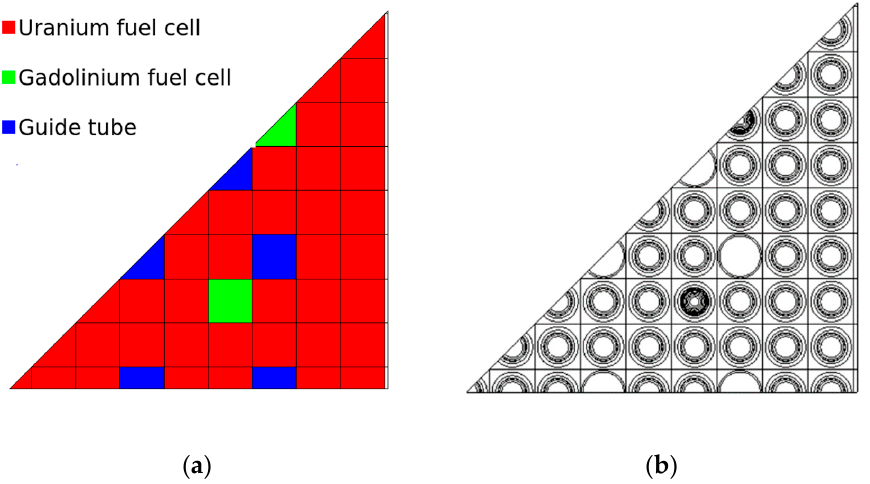
Figure 3. Construction of PWR assembly eighth by dereferentiation. ( a ) Grid layer with reference map. ( b ) Dereferenced output. map. ( b ) Dereferenced